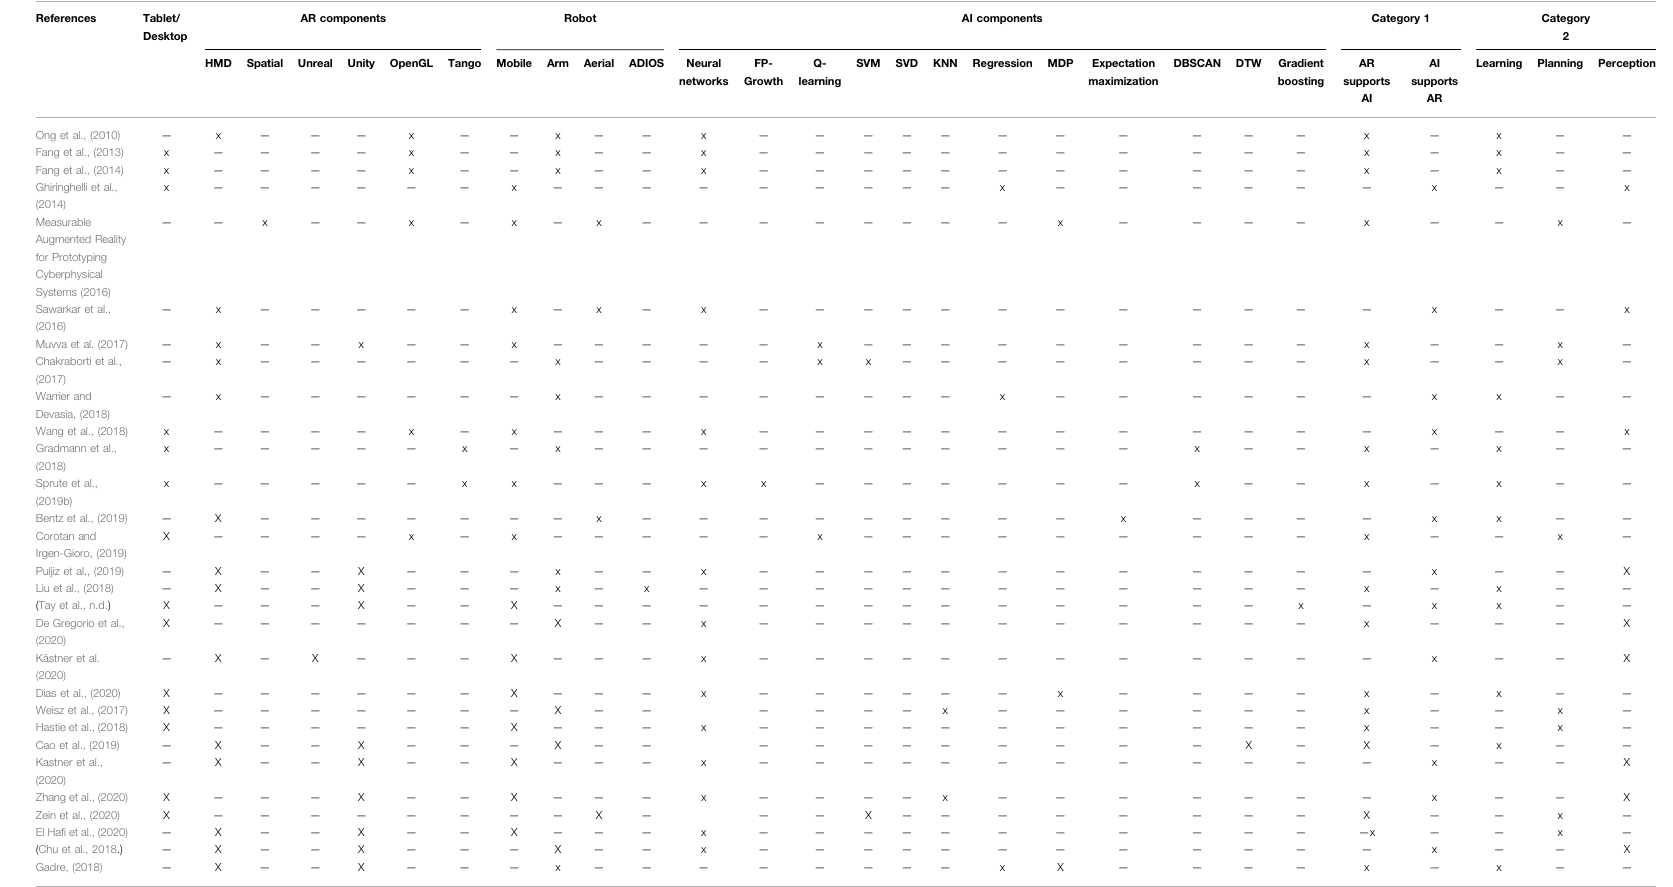
TABLE 1 | Descriptive elements on the type of the used AR Component, robotics platform, AI component, and categorization for all reviewed papers.